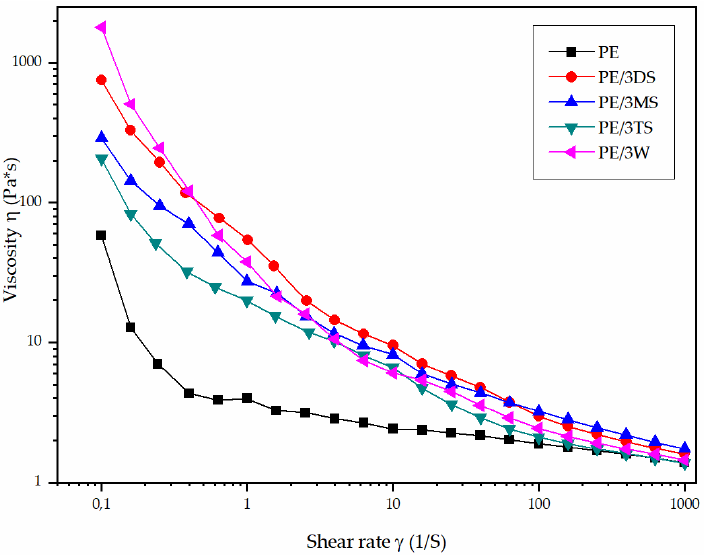
Figure 16. The variation of viscosity as a function of shear rate for a pure epoxy matrix and epoxy suspensions containing 3.0 wt % nanofiller. The experiment was conducted at 25 °C.